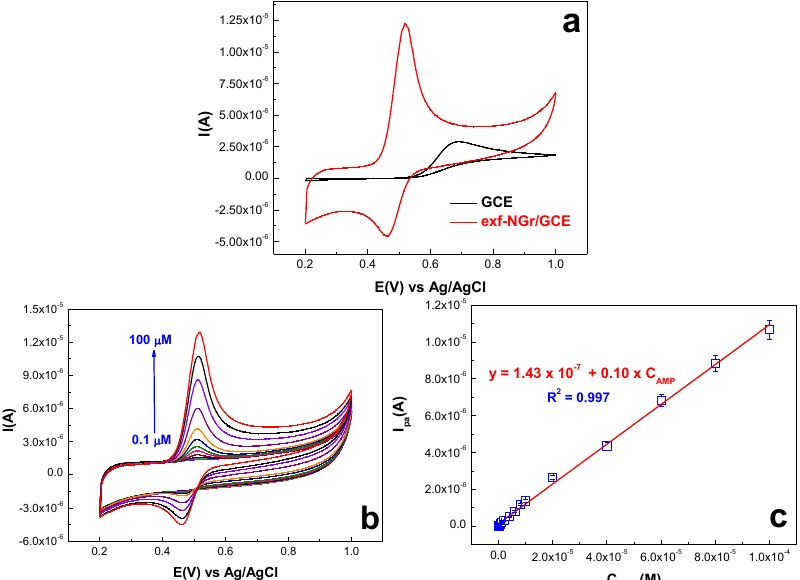
Figure 7. ( a ) Cyclic voltammograms of bare GCE and exf ‒ NGr/GCE ‒ modified electrodes recorded in acetate buffer (4.4) in the presence of 100 µM AMP, scan rate 10 mV/s ( b ) CVs recorded with exf ‒ NGr/GCE ‒ modified electrode in acetate buffer solution containing different AMP concentration (0.1 – 100 µM), scan rate 10 mV/s; ( c ) corresponding calibration curve (peak intensity vs. AMP con- centration) for exf ‒ NGr/GCE ‒ modified electrode.